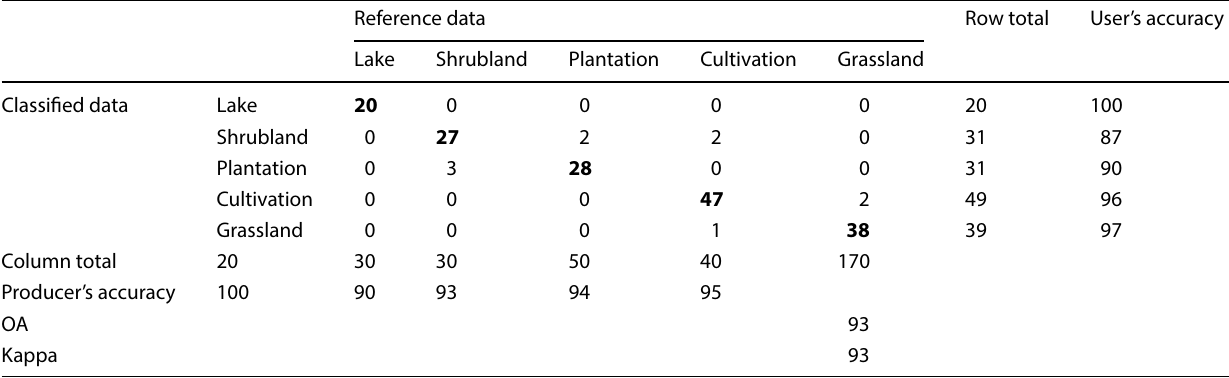
Table 3 Classification accuracy